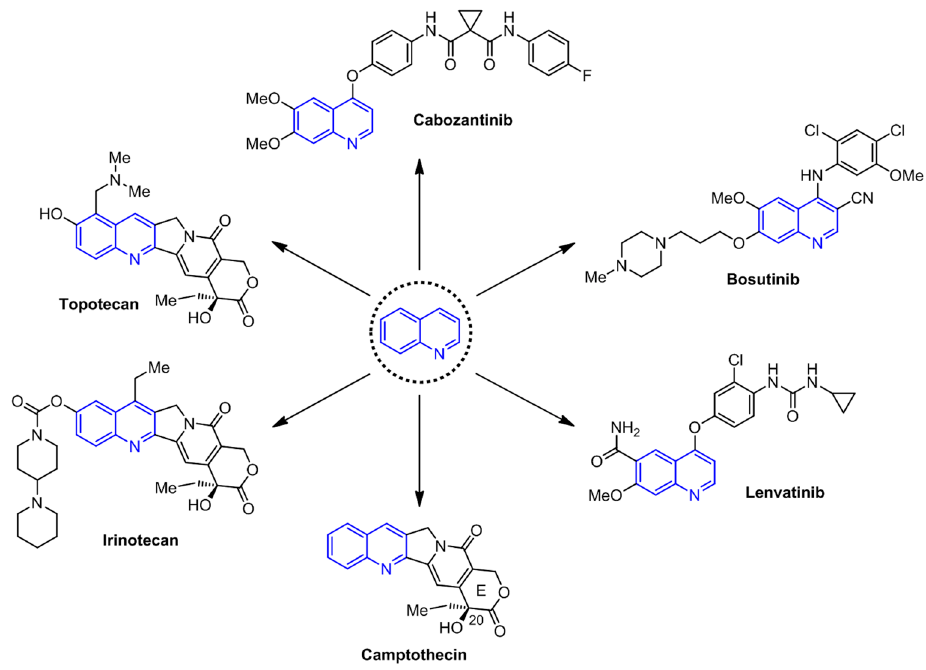
Figure 1. Some important quinoline-containing anticancer